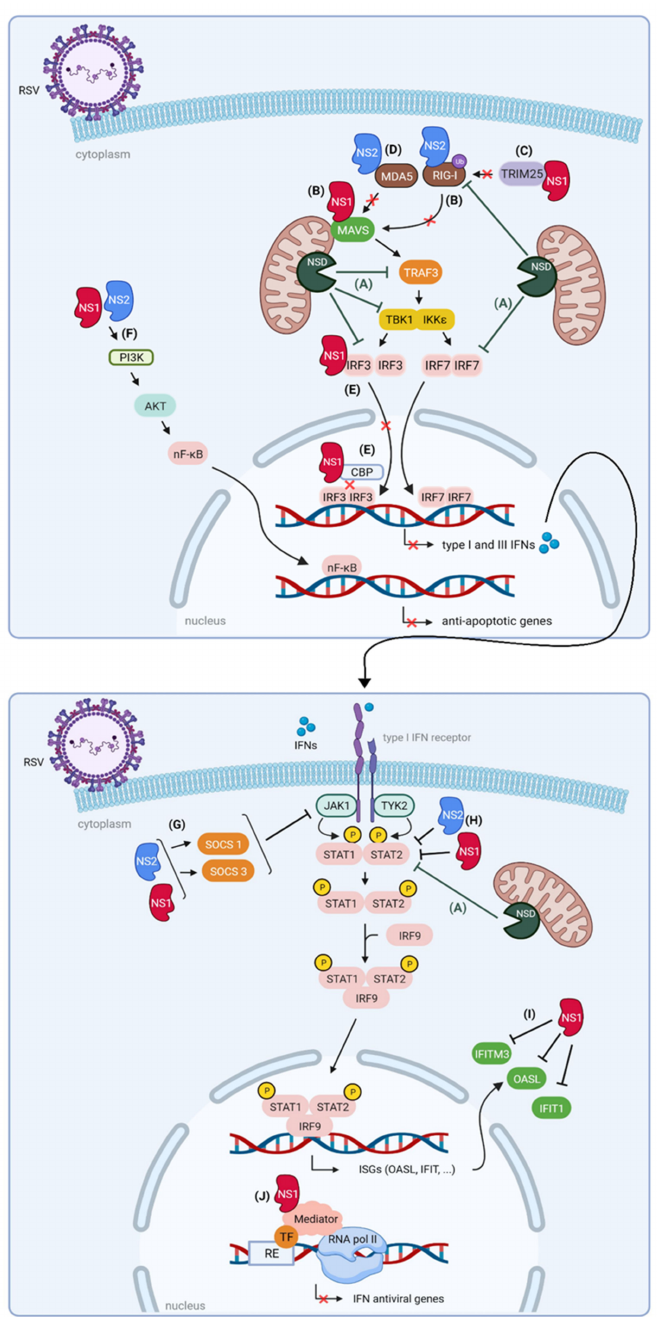
Figure 4. Proposed roles of RSV NS proteins in suppression of host innate immune responses. NS1 and NS2 can target different proteins that are necessary for the host antiviral immune